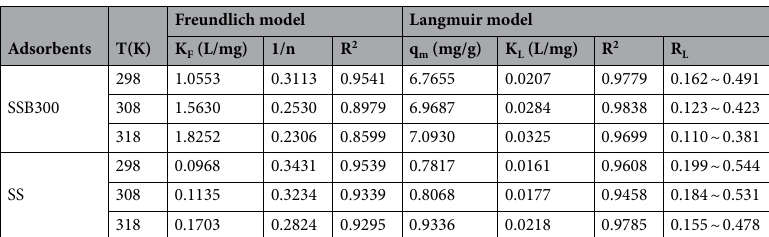
Table 3. Isothermal adsorption fitting parameters of